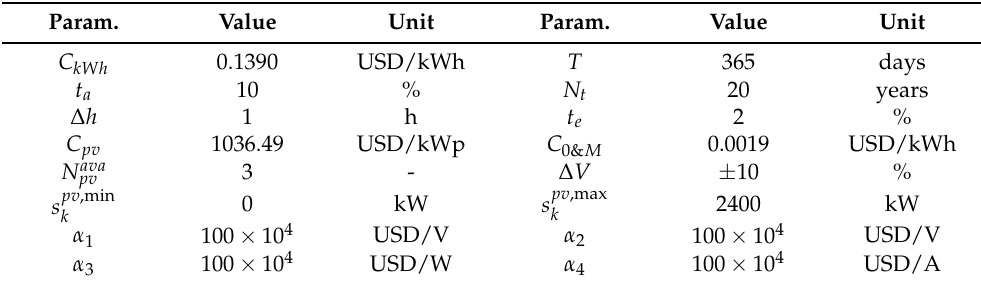
Table 1. Parameters for the optimal integration of PV sources into electrical grids. Param.